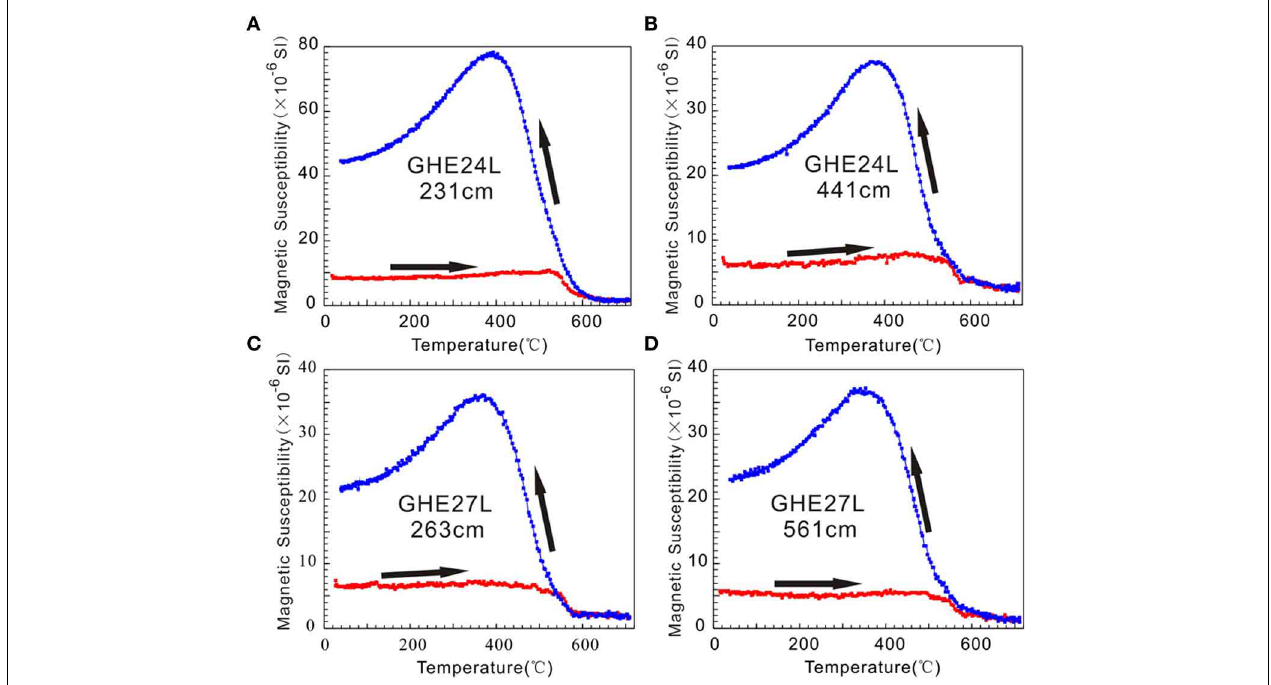
features with a rapid decline in magnetic susceptibility at around 580 ◦ C during heating and elevated magnetic susceptibility during cooling.